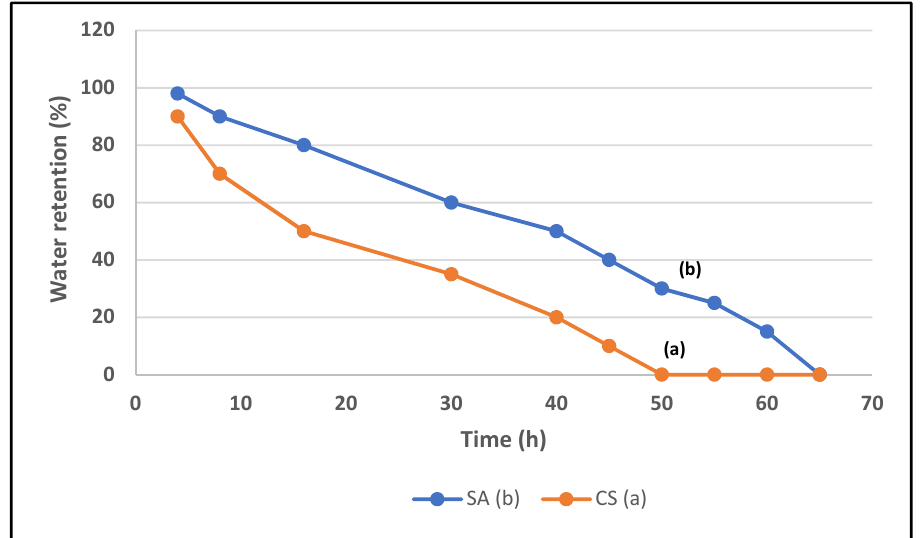
Figure 7. Water retention of SA (%G = 60.65) (b) as compared to that of CS (a).